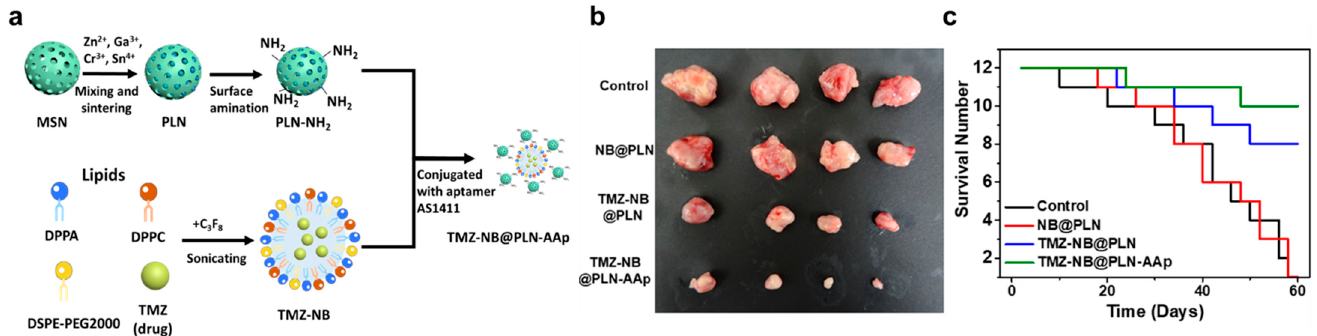
Figure 7. ( a ) Schematic illustration of nanosystem preparation and surface functionalization [75]. ( b ) The tumor sizes after different treatments. (c) The change in the survival number of the mouse over time. Adapted with permission from Ref. [75]. Copyright 2021 American Chemical Society.